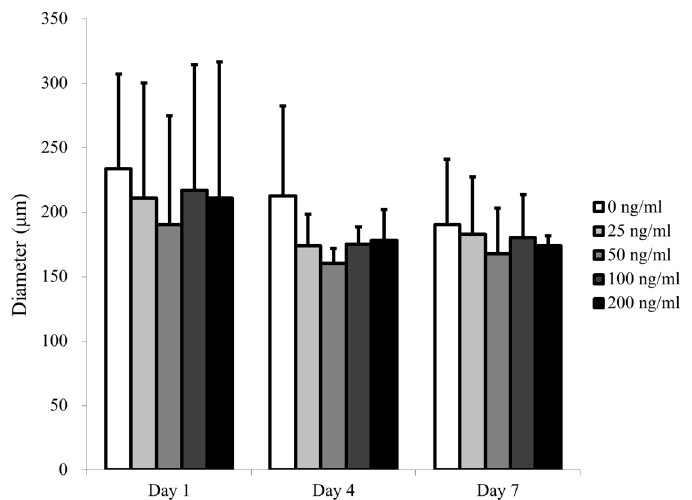
Figure 3. The diameters of the stem cell spheroids on Days 1, 4, and 7. p > 0.05 between time-matched groups.